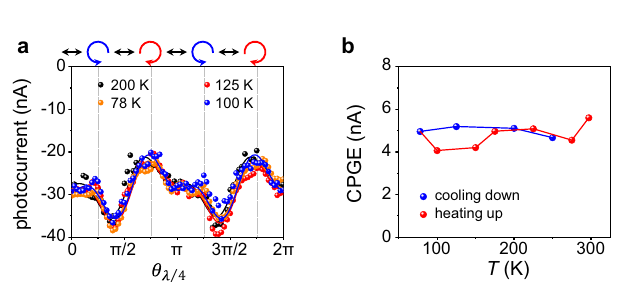
Fig. 3 | Power-dependent and spatial-resolved CPGE in Te. a Power-dependent CPGE under 10.6- μ m excitation at positions with the maximal positive (red) and negative (blue) responses on another Te device. c θ λ = 4 -dependent photocurrent under10.6- μ mexcitationatpositionswiththe maximalpositive(red)and negative